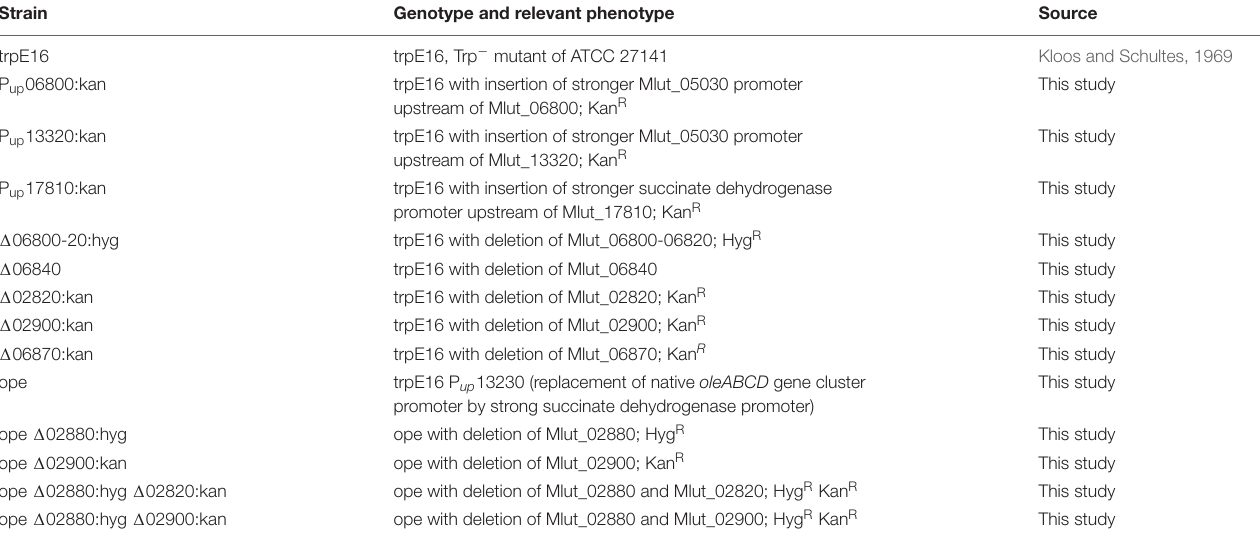
TABLE 1 | M. luteus strains used in this